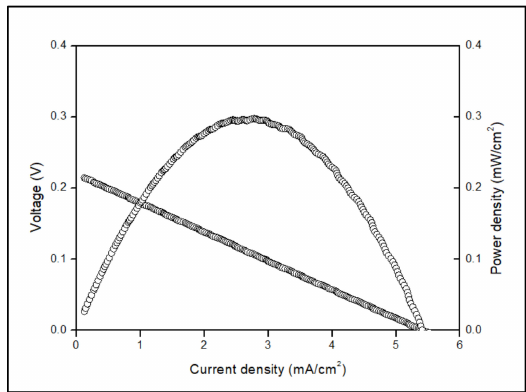
Figure 6. Power density of single cell at 700 ◦